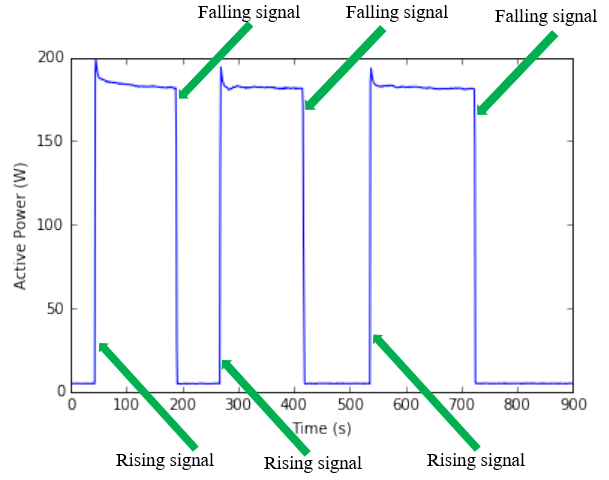
Figure 8. The analysis of active power signal with rising and falling signal.